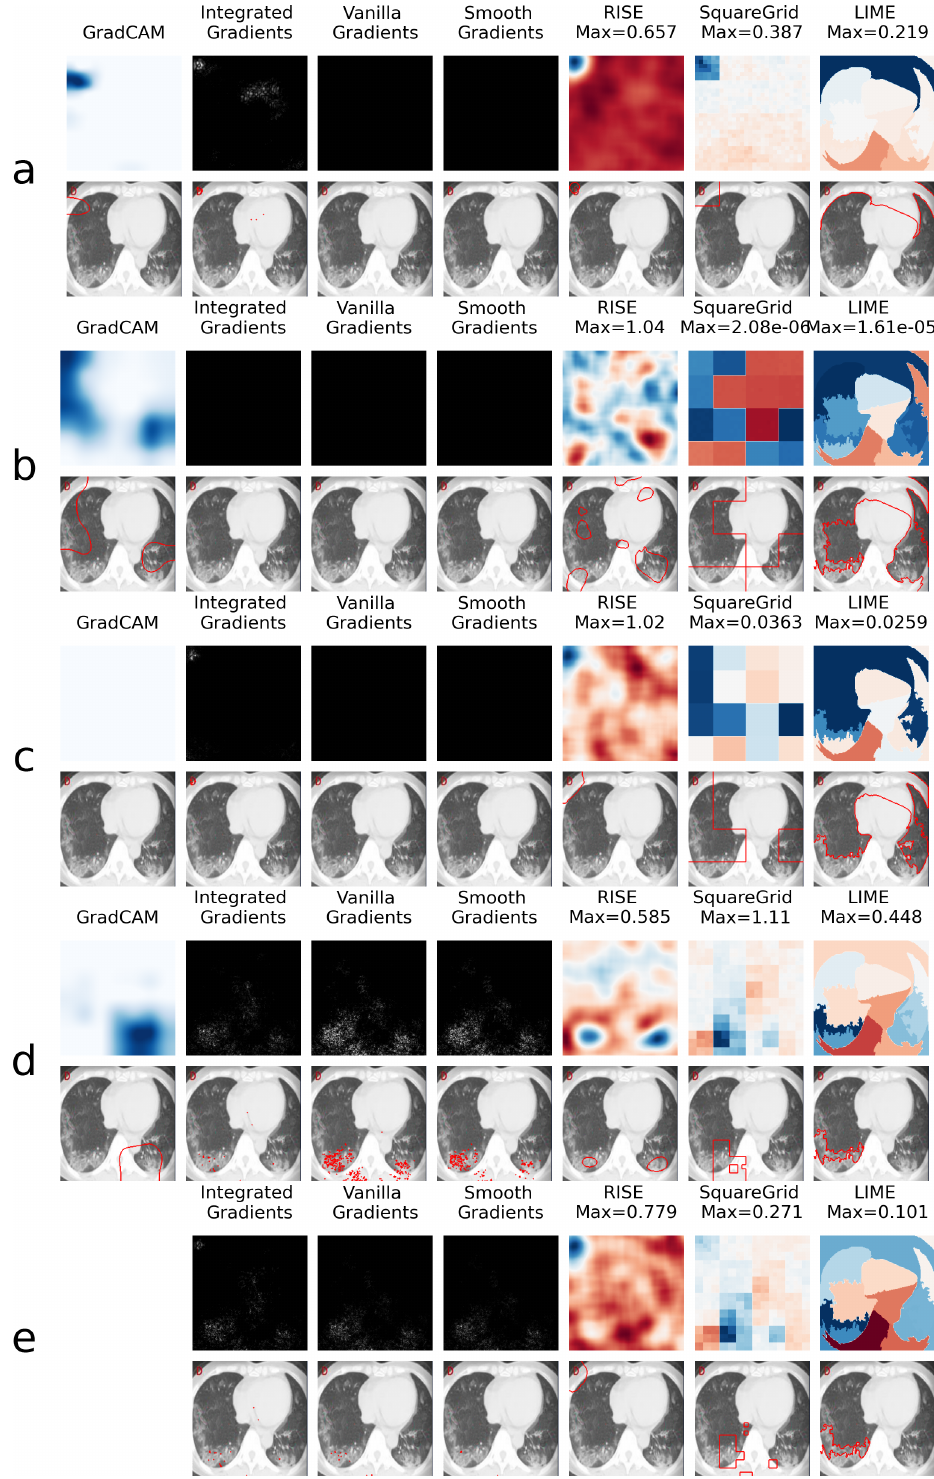
Figure 4. Comparison of XAI heatmaps for image with colored artifact: ( a ) VGG val 831 . ( b ) Ef f val 856 . ( c ) Dense val 898 . ( d ) Dense val 907 . ( e ) Ensemble. Top row for each panel shows the heatmaps, while bottom row highlights the areas of highest heatmap weights. Note that GradCAM is not defined for ensembles of models. The scales for the heatmaps go from 0 to 1 for GradCAM, minimum to maximum for RISE and -maximum to maximum for Squaregrid and